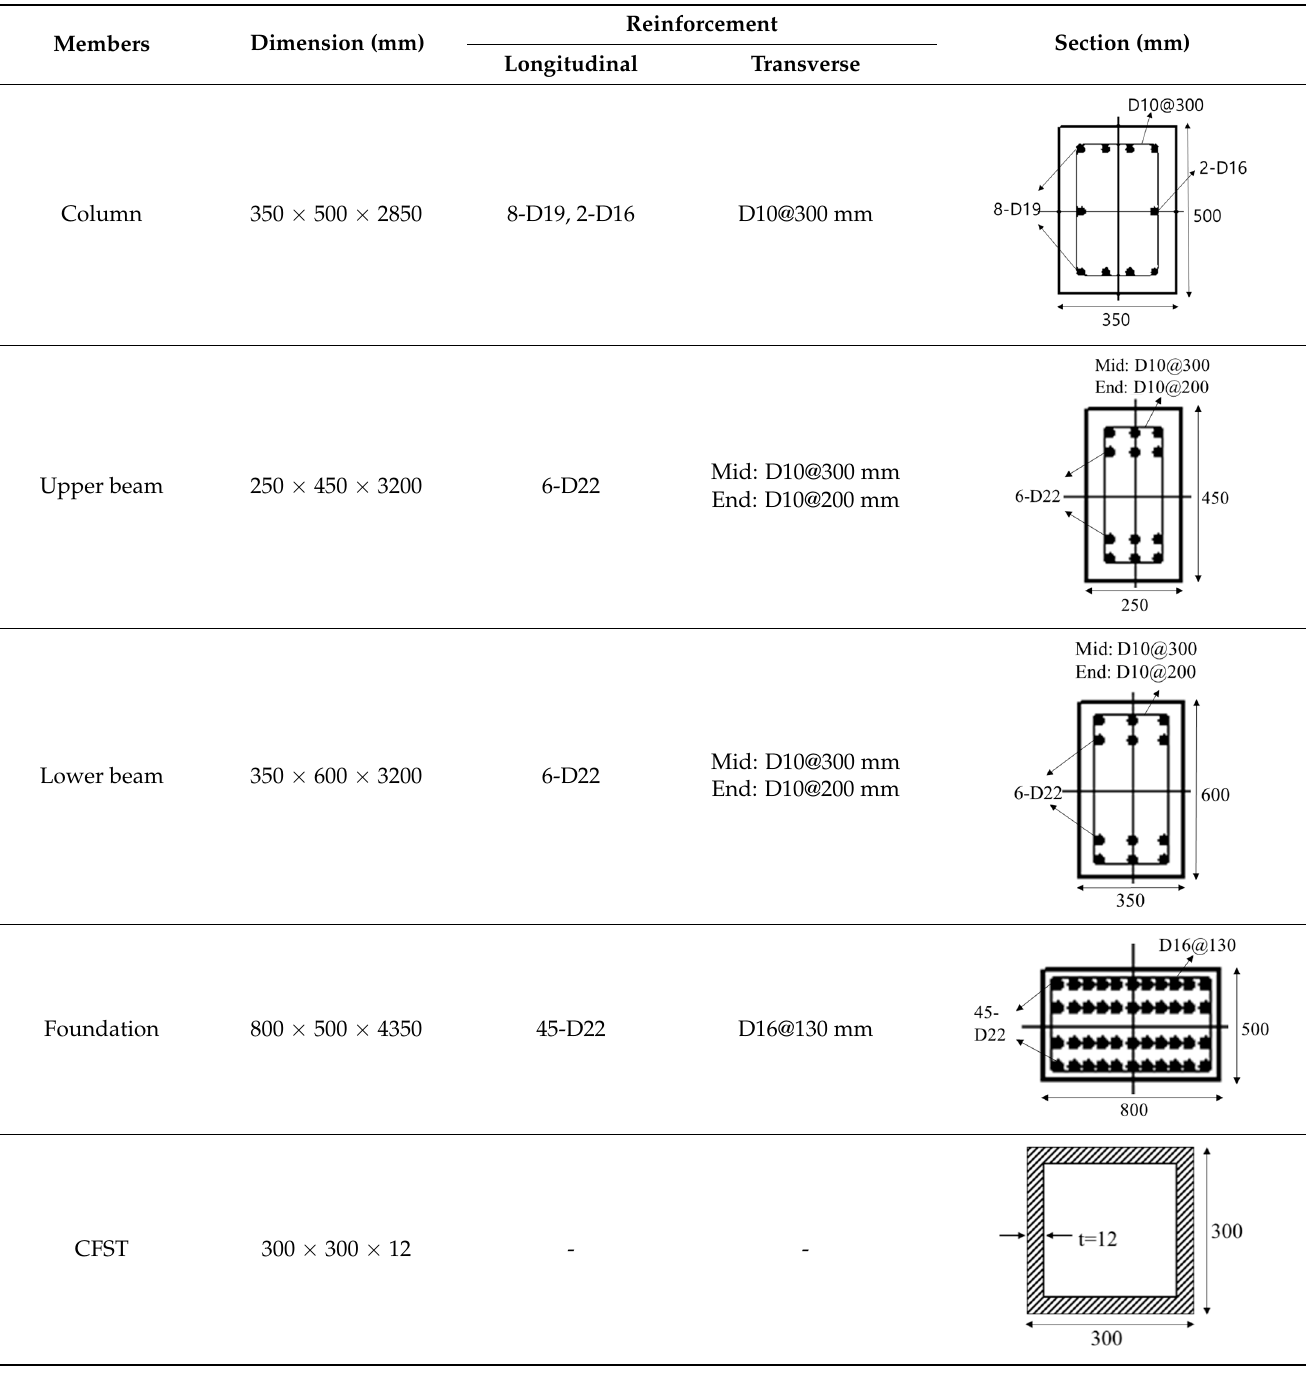
Figure 3. Benchmark structures. ( a ) Exterior elevation; ( b ) floor plan (mm).